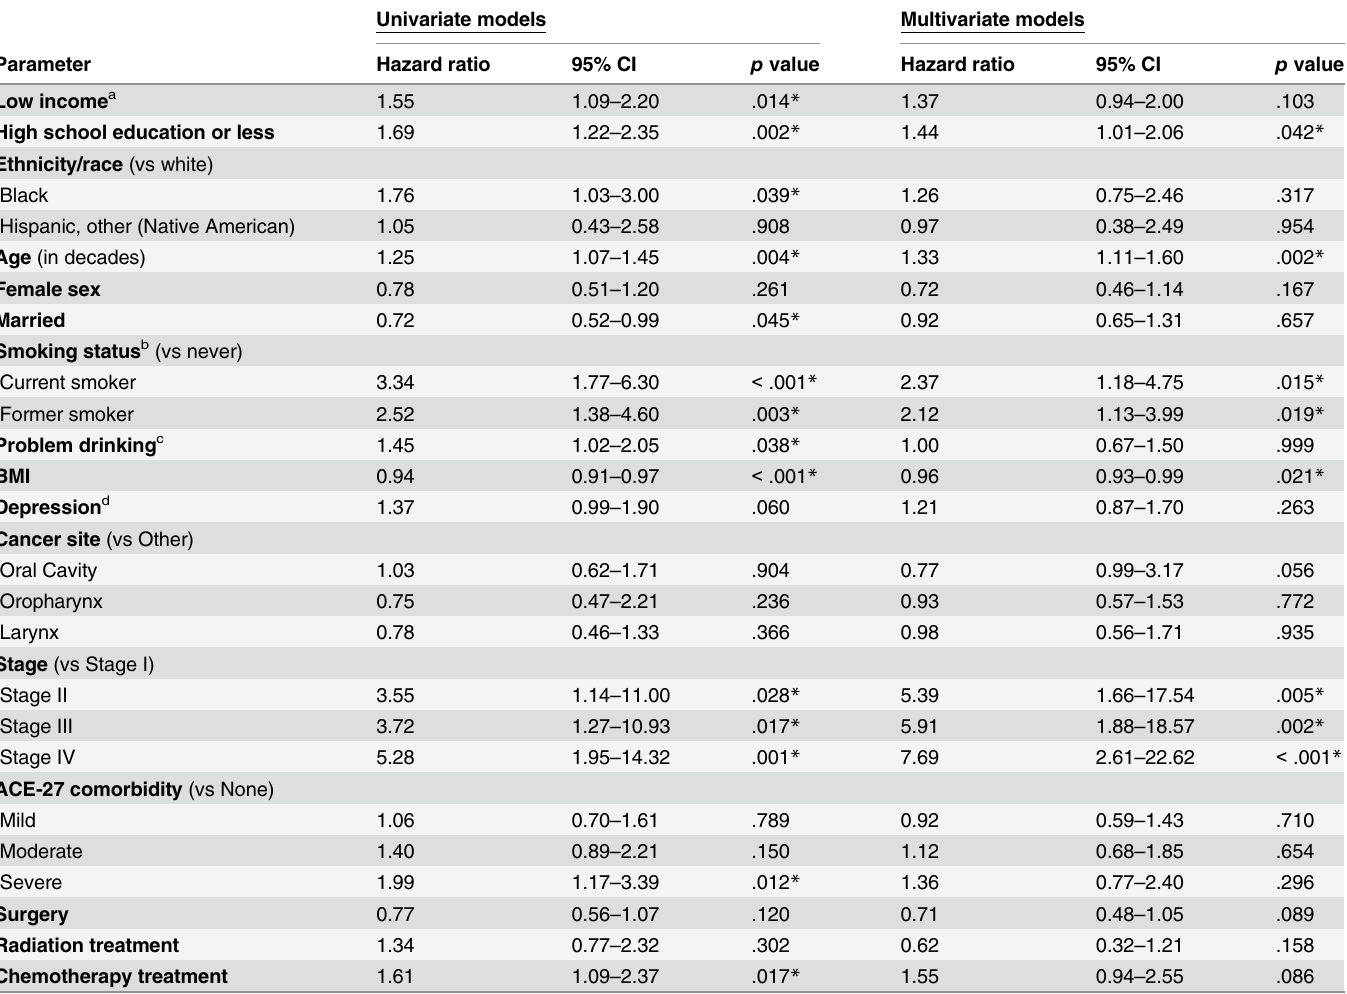
Table 4. Univariate and multivariate Cox proportional hazards model for 5-year cancer-specific survival (N = 634 [147 events, 487 censored]). Univariate